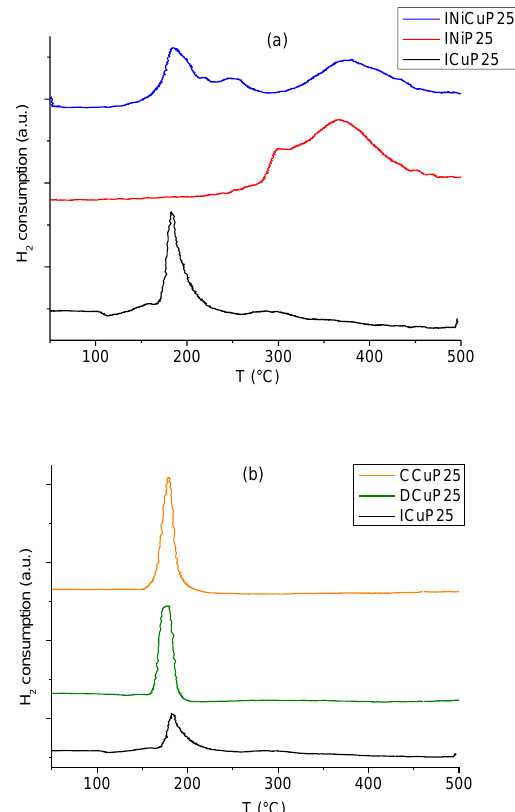
Figure 5. (a ) TPR analysis of the samples made of TiO 2 P25 loaded with various impregnated oxides at 1.0 wt % total metal loading; ( b ) CuO introduced by various techniques at 1.0 wt %.